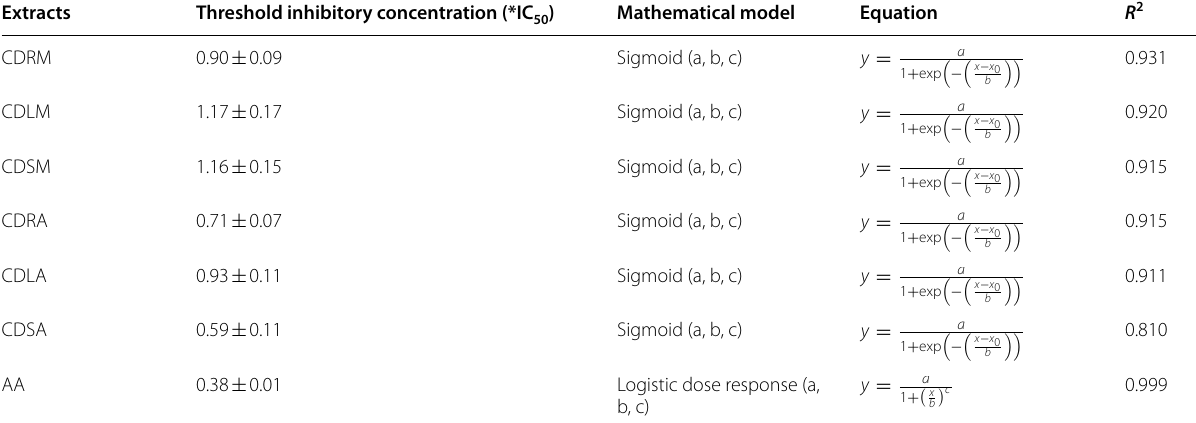
) of crude aqueous and methanol extracts of C. dependens and ascorbic acid standard 50